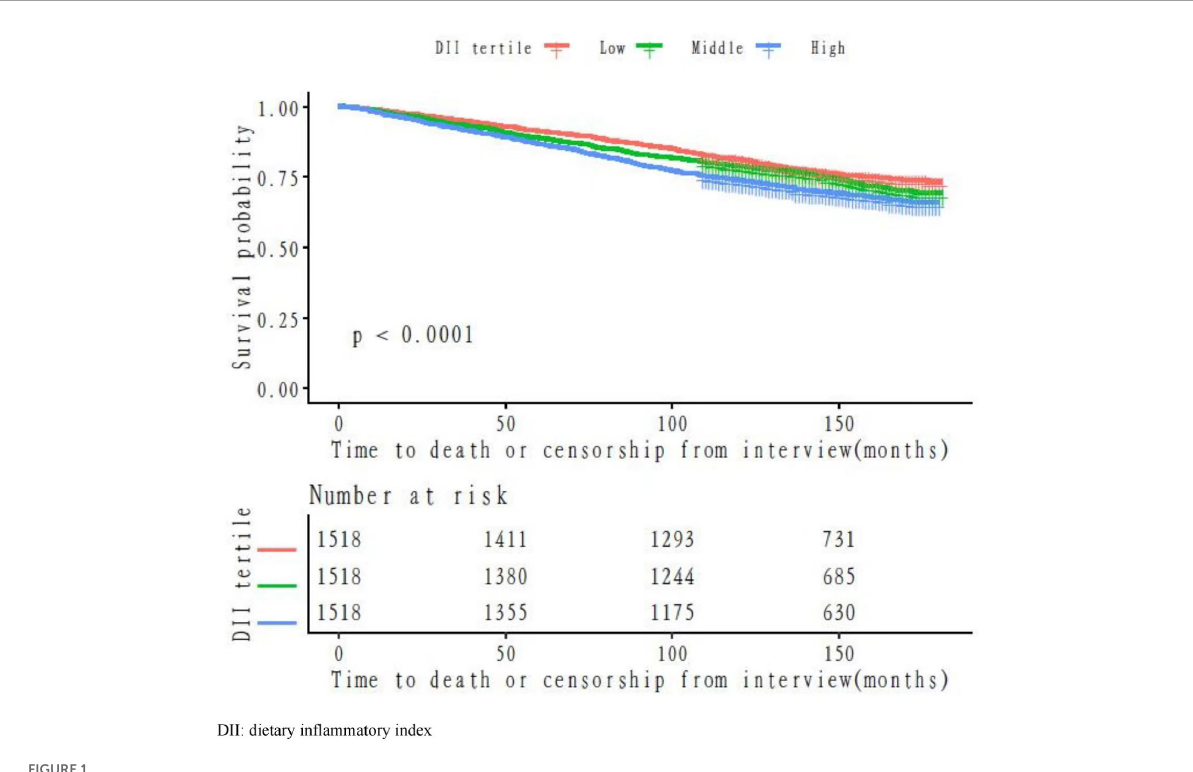
FIGURE1 Survival probability by the level of the dietary inflammatory index